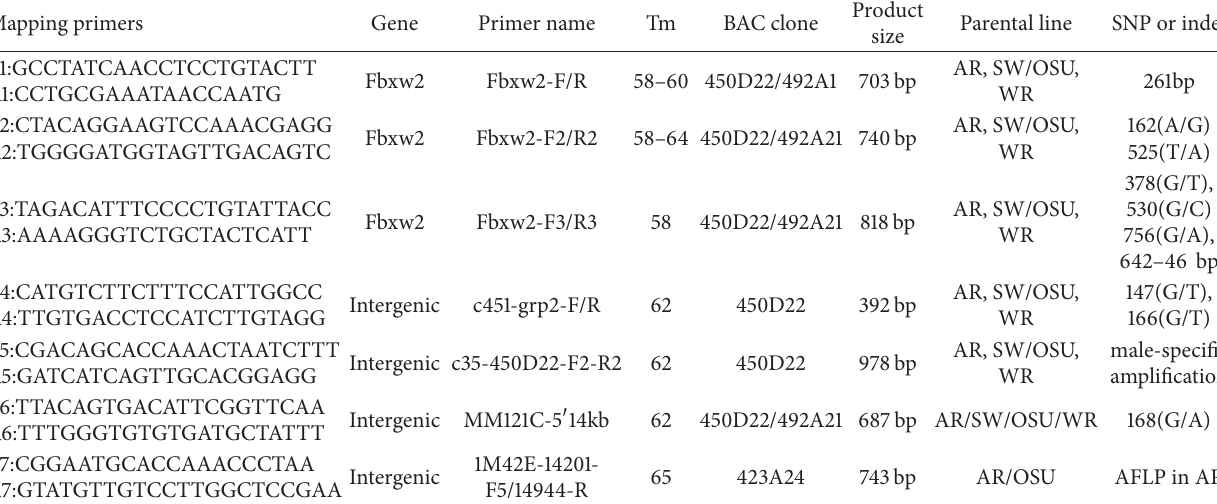
Table 3: Primer information for markers in the OmyY1 BAC contig (#6256).The parental lines are the doubled haploid male (AR/SW) and female (OSU/WR) rainbow trout clonal lines in which the products were amplified. Clonal lines listed on either side of “/” denote which clonal lines have the SNP or indel. The last column shows the base pair location of the SNP(s) or indel in the amplified product. Mapping primers Gene Primer